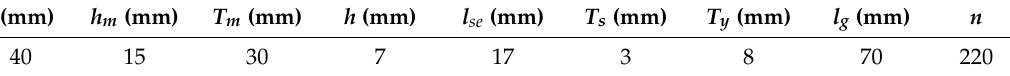
Figure 8. Photo of the electromagnetic actuator prototype. Table 1. Geometric parameters of an electromagnetic actuator.